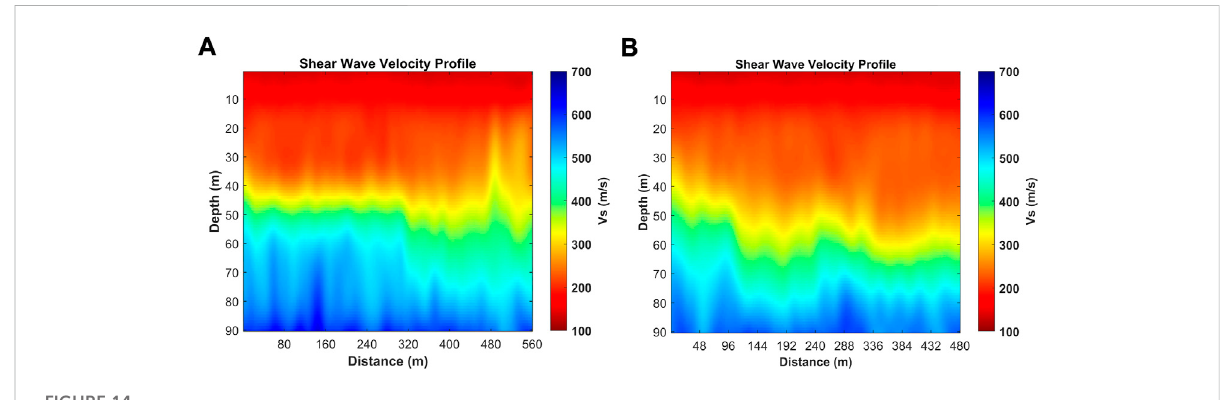
FIGURE 14 The 2D shear wave velocity pro fi les along the DAS Line I (A) and Line II (B)